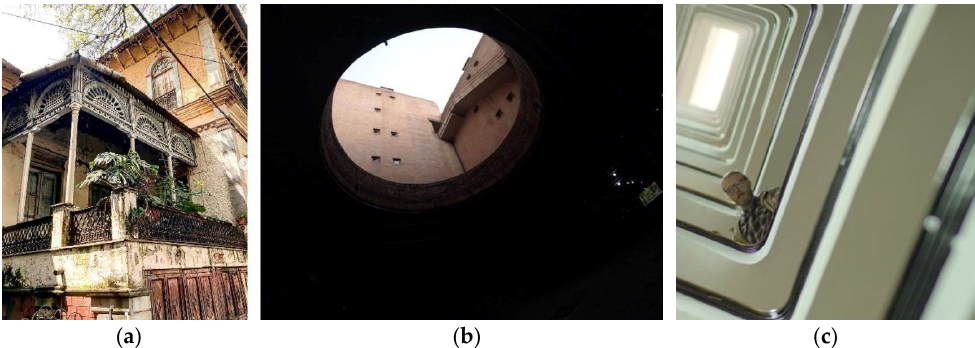
Figure 6. Architectural heritage pictures collected from #patrimonioarquitectonico in Instagram